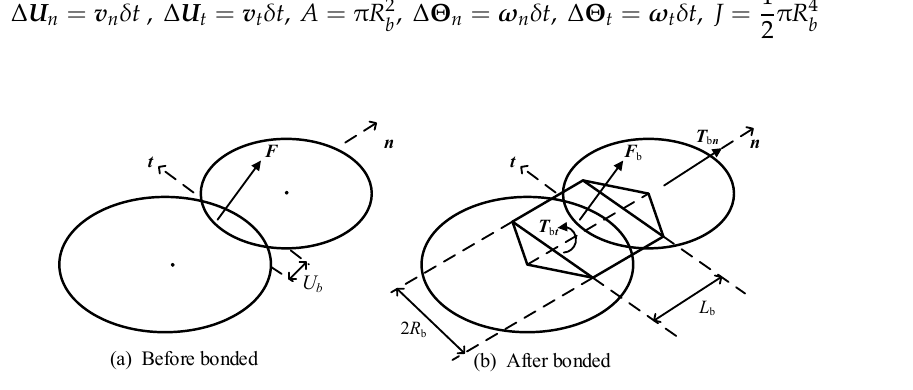
Figure 5. Force–displacement model of particle bonds.